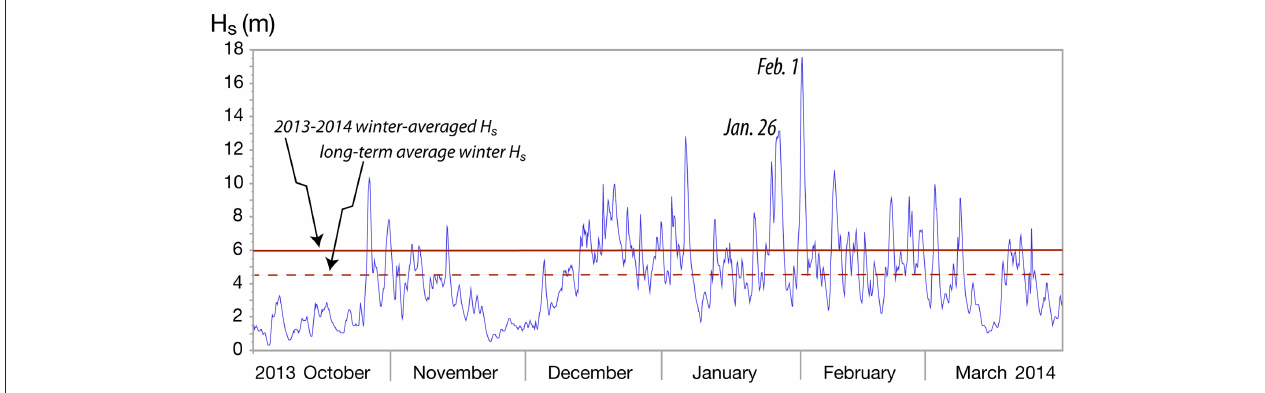
FIGURE 4 | Sea states at the 62095/M6 location in winter 2013-2014 (October-March), derived from satellite data available at ftp.ifremer.fr/ifremer/cersat/products/ swath/altimeters/waves. (Database is described in Queffeulou, 2013). Average winter H s values are from Masselink et al.